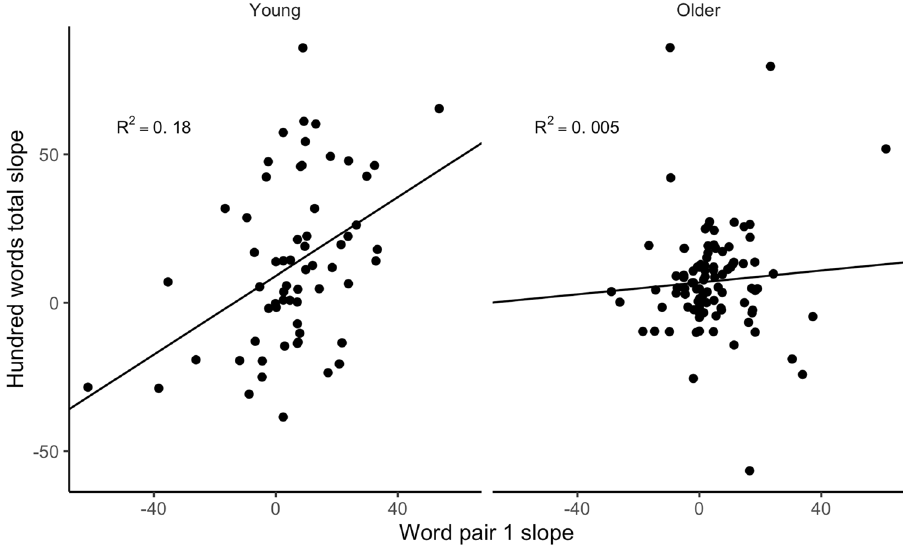
Figure 6. Correlation between the slopes on the 100-words test and the word-pair